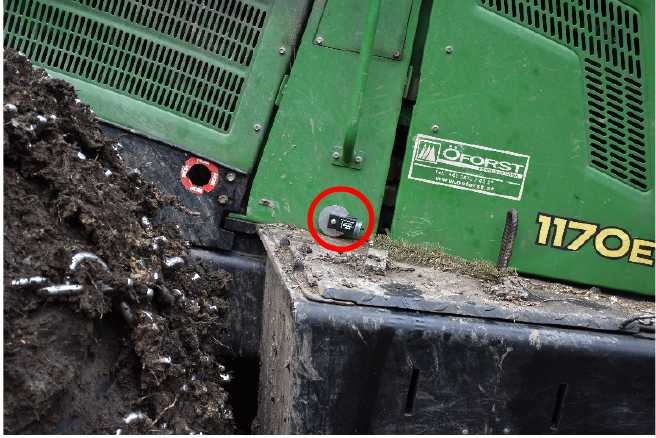
Figure 4. The location of the mounted acceleration data logger on the rear frame of the machinery.